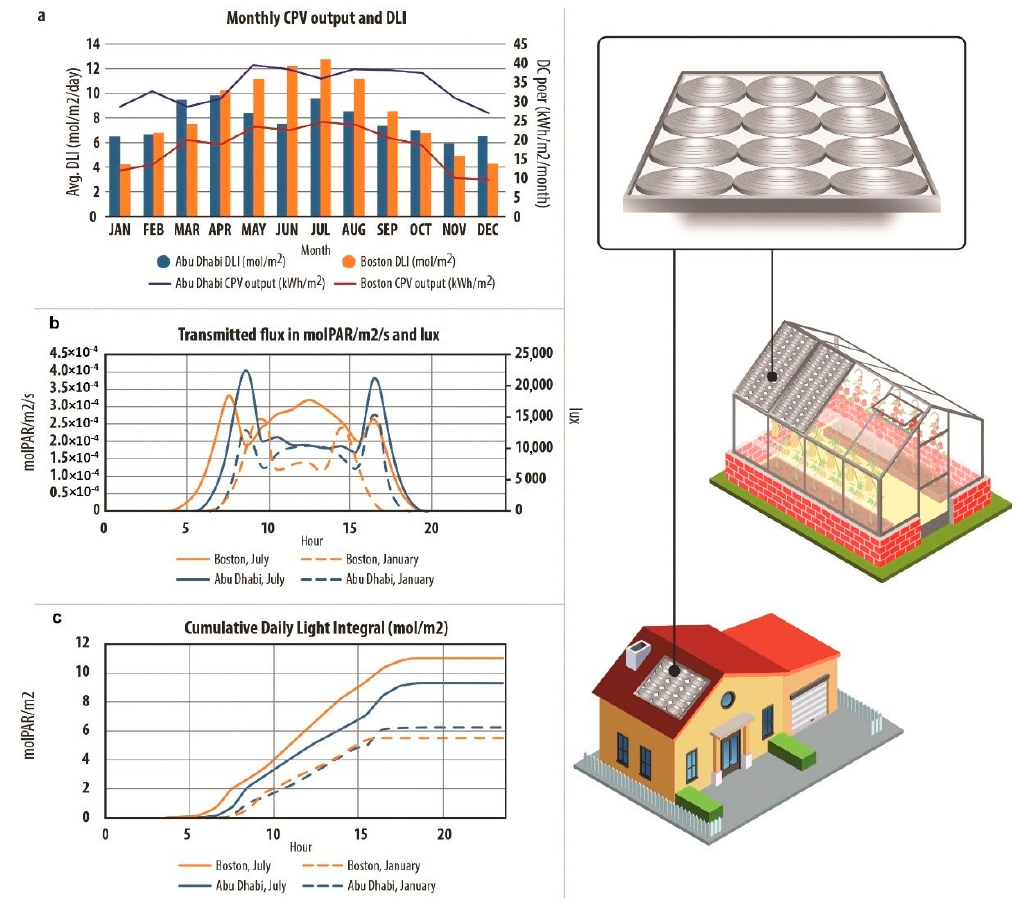
Figure 4. Transmission through described partially-transparent tracking-integrated CPV module (application concept right) in terms of ( a ) monthly average PAR daily light integral simulated in Boston (red) and Abu Dhabi (blue); ( b ) daily transmitted profile in terms of PAR (left axis) and lux (right axis) for July (solid line) and January (dashed line); ( c ) cumulative DLI for typical day in both locations in both months. Recommended indoor lighting levels are typically 1000 lux or less (direct sunlight is ~100,000 lux). DLI of <10 mol/m 2 /day are considered suitable for low-light crops [34]. On the right-hand side, applications concepts as skylights or in greenhouses.